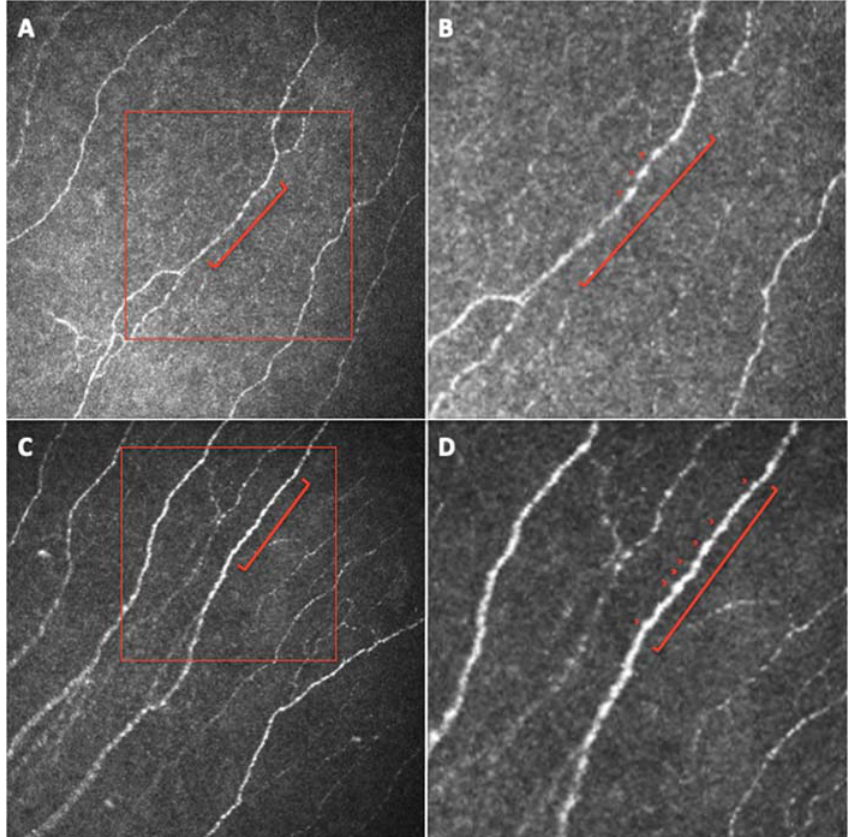
Figure 3. In-vivo corneal confocal microscopy images of the sub-basal nerve plexus of ( A , B ) a patient recovered from coronavirus disease 2019 (COVID-19) and ( C , D ) a healthy subject. Red lines in ( A , C ) indicate 100 microns of fiber; ( B , D ): magnification of red boxes in ( A , C ), respectively. Red arrowheads indicate corneal nerve